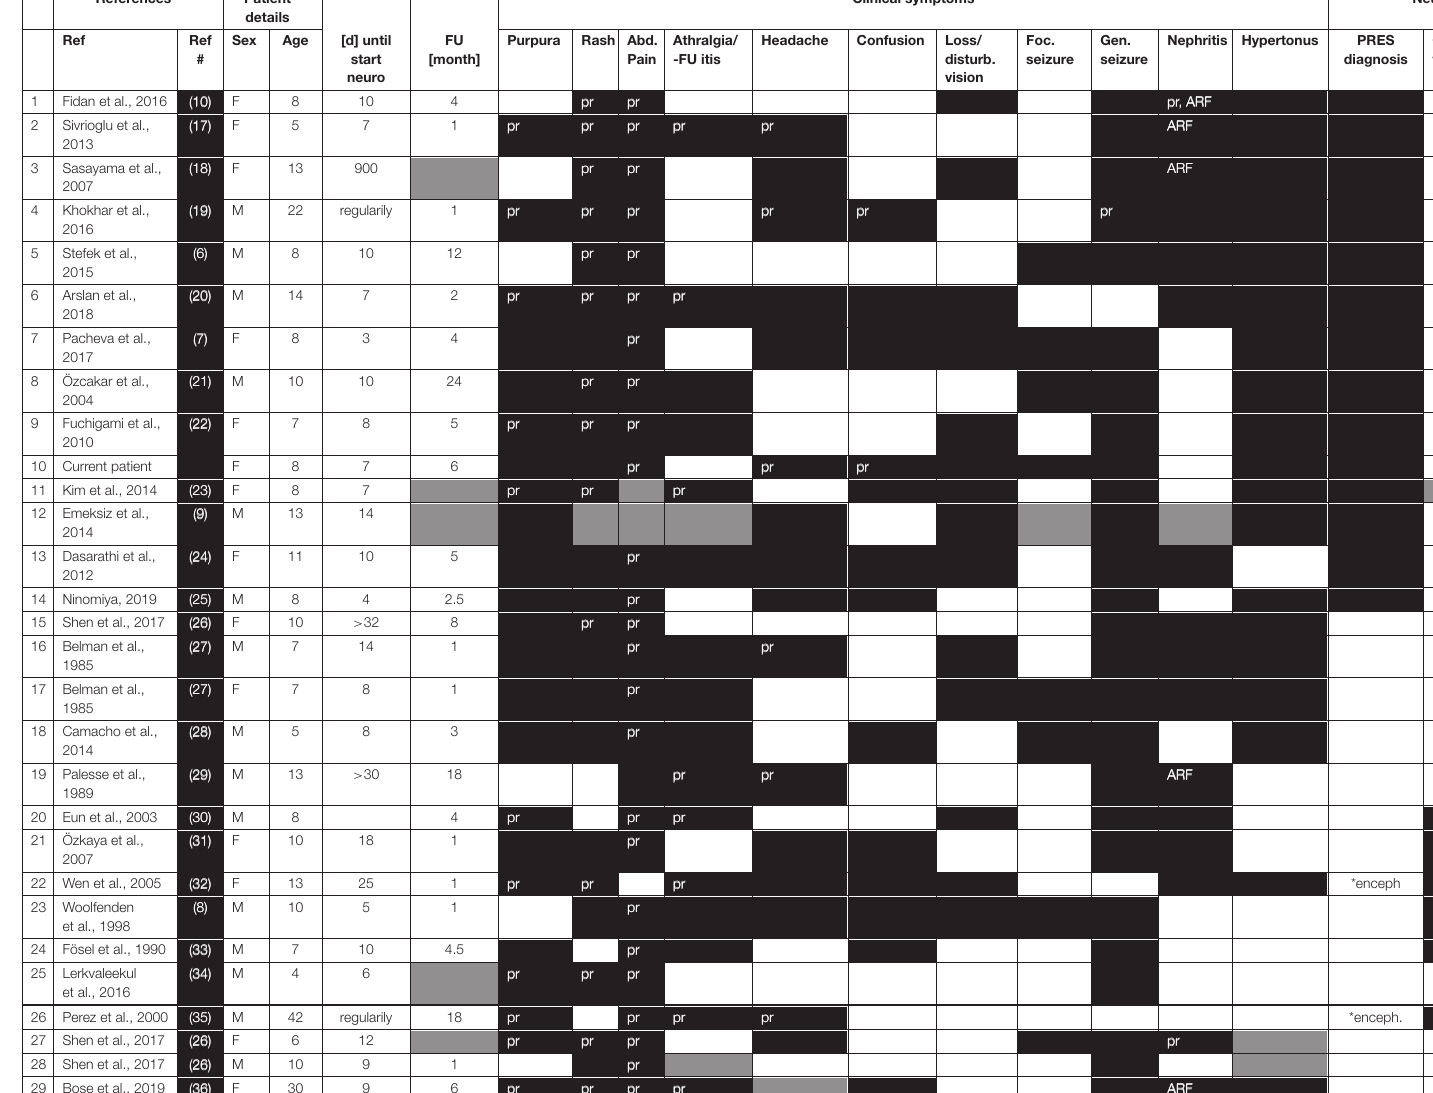
27 Shen et al., 2017 (26) F pr 28 Shen et al., 2017 (26) M pr 29 Bose et al., 2019 (36) F pr ARF Black, affected; white, not affected; gray, information missing. Pr, presenting sign; F, female, M, male, FU, follow up. Ref, Reference given as the name of first author and year of publication; Ref #, number of the cited publication in the reference list of this article. [d] until neuro, days from the presenting symptoms until the first clinical-neurological symptoms; and. pain, abdominal pain; loss/disturb. vision, visual disturbance as defined as disturbed vision or loss of vision; foc. seizure, focal seizure with or without secondary generalization; gen. seizure, generalized tonic-clonic seizures; nephritis, nephritis or other form of renal impairment up to ARF, acute renal failure; cer. vasc., confirmed diagnosis of cerebral vasculitis; RCVS, reversible cerebral vasoconstriction syndrome; * enceph, encephalopathic patients, reported diagnosis of cereb. Vasculitis but PRES possible; neuro sequelae, clinically manifest neurological impairment of body functions, imaging or EEG findings consistent with functionally not relevant scars after, e.g., infarction were counted as